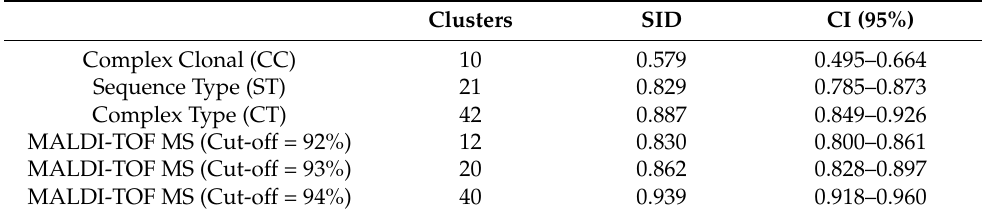
Table 1. Simpson’s index diversity (CI 95%) for typing schemes